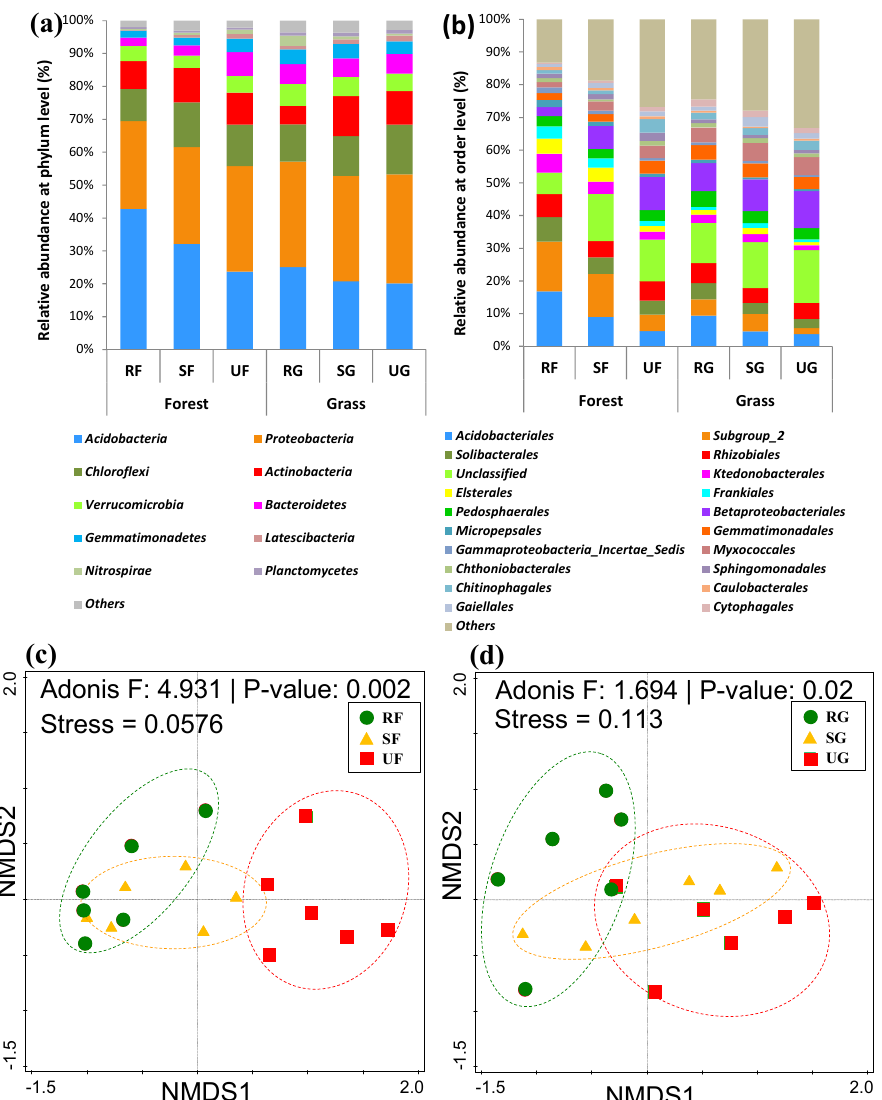
Figure 3. Relative abundance of the bacterial community at the phylum ( a ) and order ( b ) level along the rural-suburban-urban gradient; and the non-metric multidimensional scaling (NMDS) analysis of the bacterial community in forestland ( c ) and grassland ( d ) at the OTU level. Groups with <1% sequence number were merged into the “Others” taxa. RF, SF, UF, RG, SG and UG represent rural forestland, suburban forestland, urban forestland, rural grassland, suburban grassland and urban grassland, respectively.